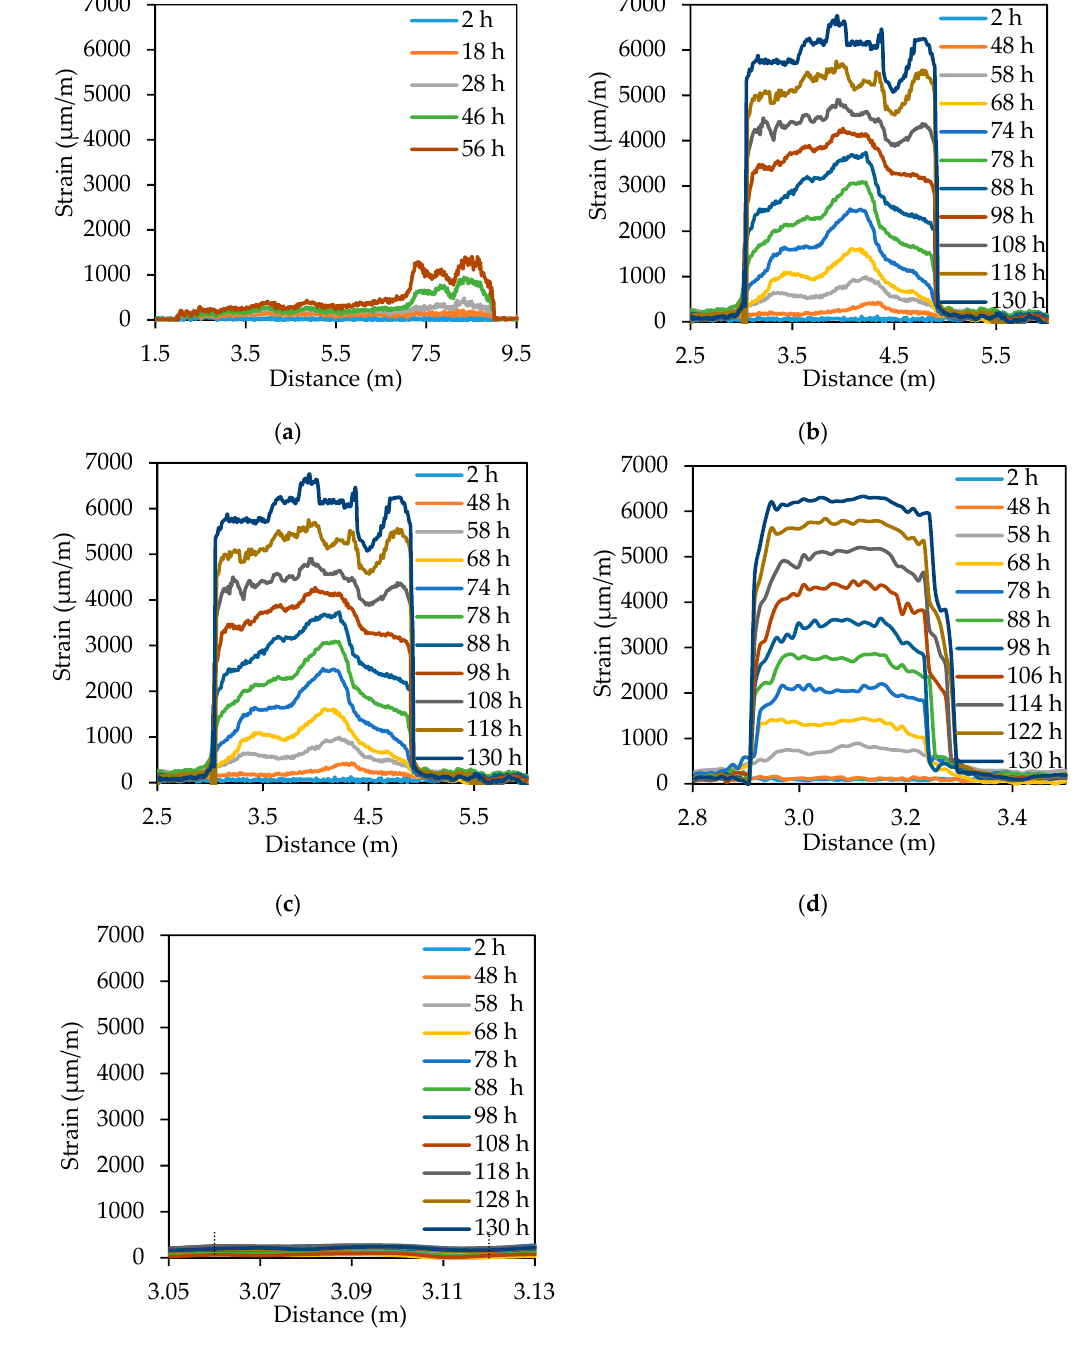
Figure 8. Detailed strain distributions along the distributed fiber optic sensor for different installation methods: ( a ) S0; ( b ) S2; ( c ) S5; ( d ) S10; and ( e )